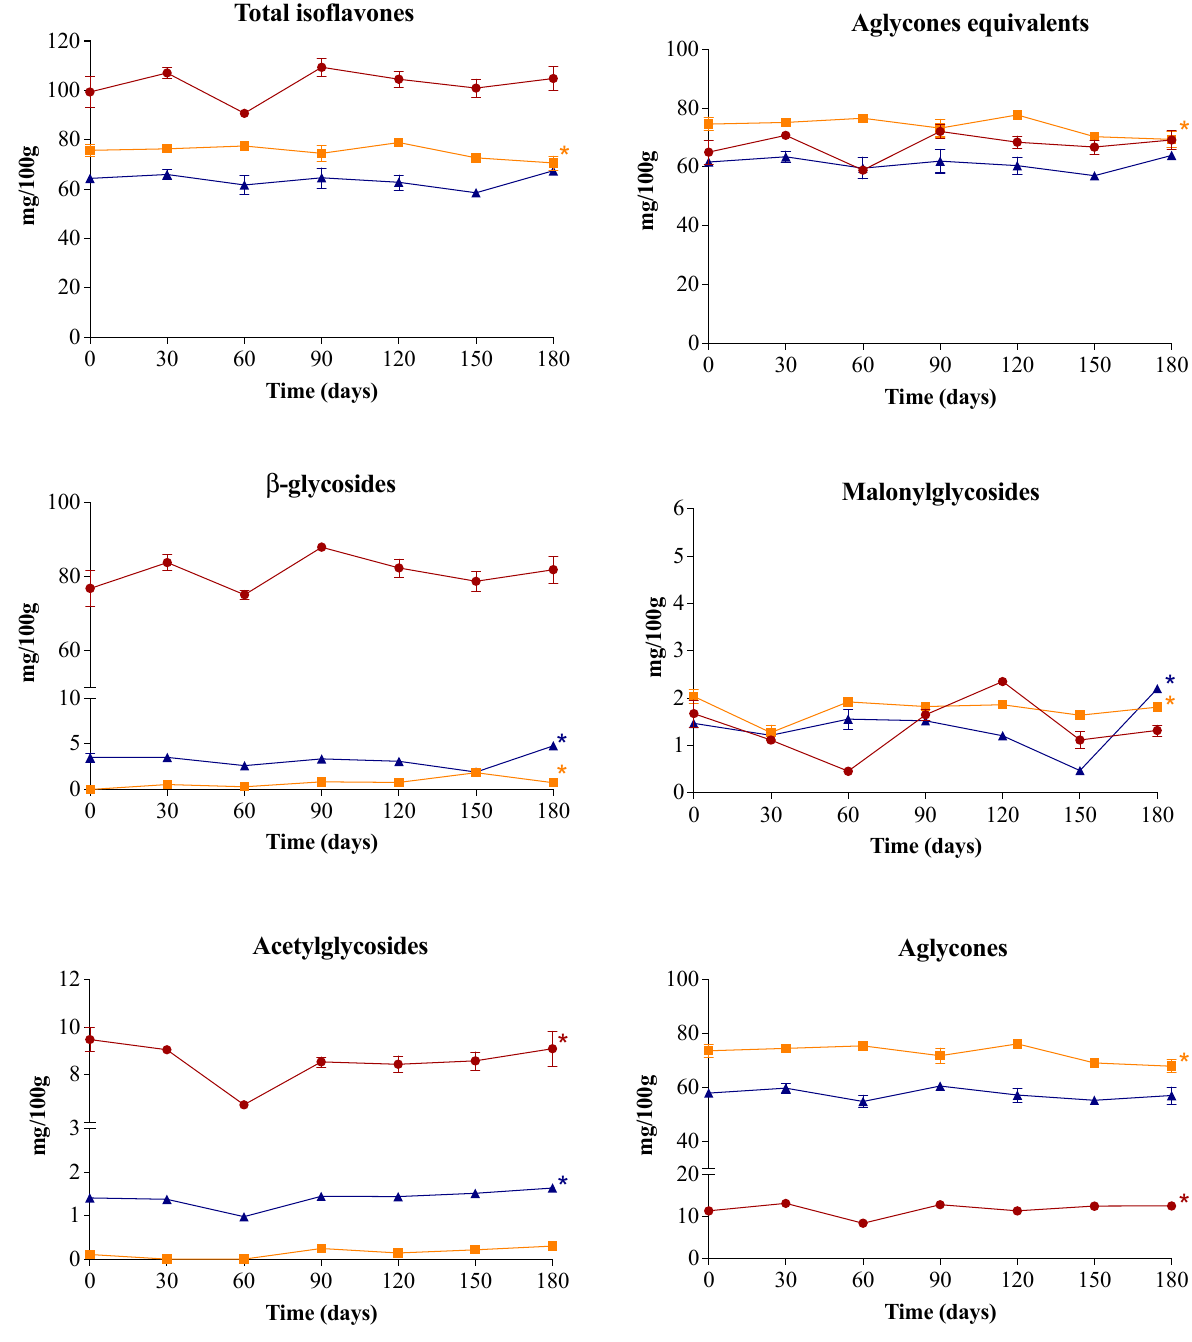
Figure 1. Contents of isoflavones and their subclasses in soybean meal (SBM) ( • ), fermented soybean meal (FSBM) ( (cid:4) ) and enzymatically-processed soybean meal (ESBM) ( (cid:78) ) biscuits during storage at 25 ◦ C for 180 days. Data expressed as mean ± standard deviation ( n = 3) on dry weight basis. Asterisks indicate significant differences between initial (day 0) and final (day 180) storage times (ANOVA followed by Dunnett’s post hoc test; p < 0.05).